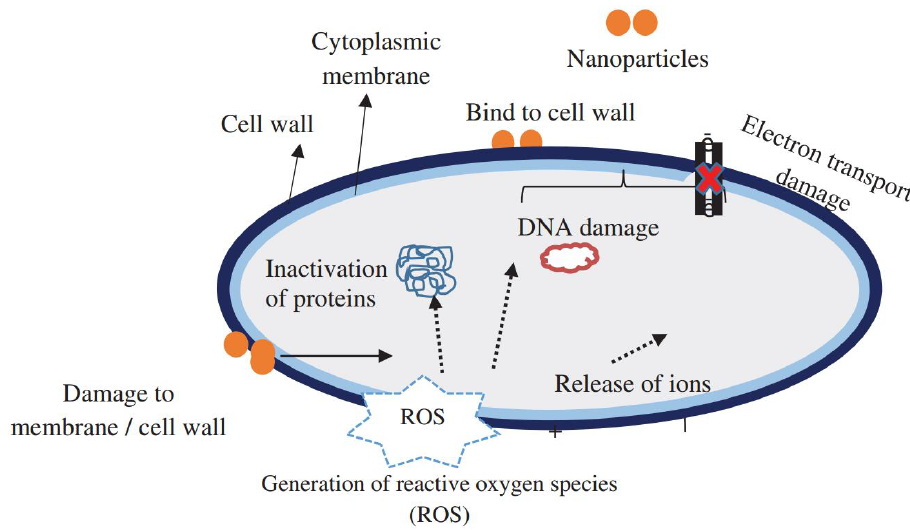
Figure 1. Schematic representation of antimicrobial mechanisms of inorganic nanoparticles. Reproduced with permission from [25]. Copyright Taylor & Francis Online, 2018.